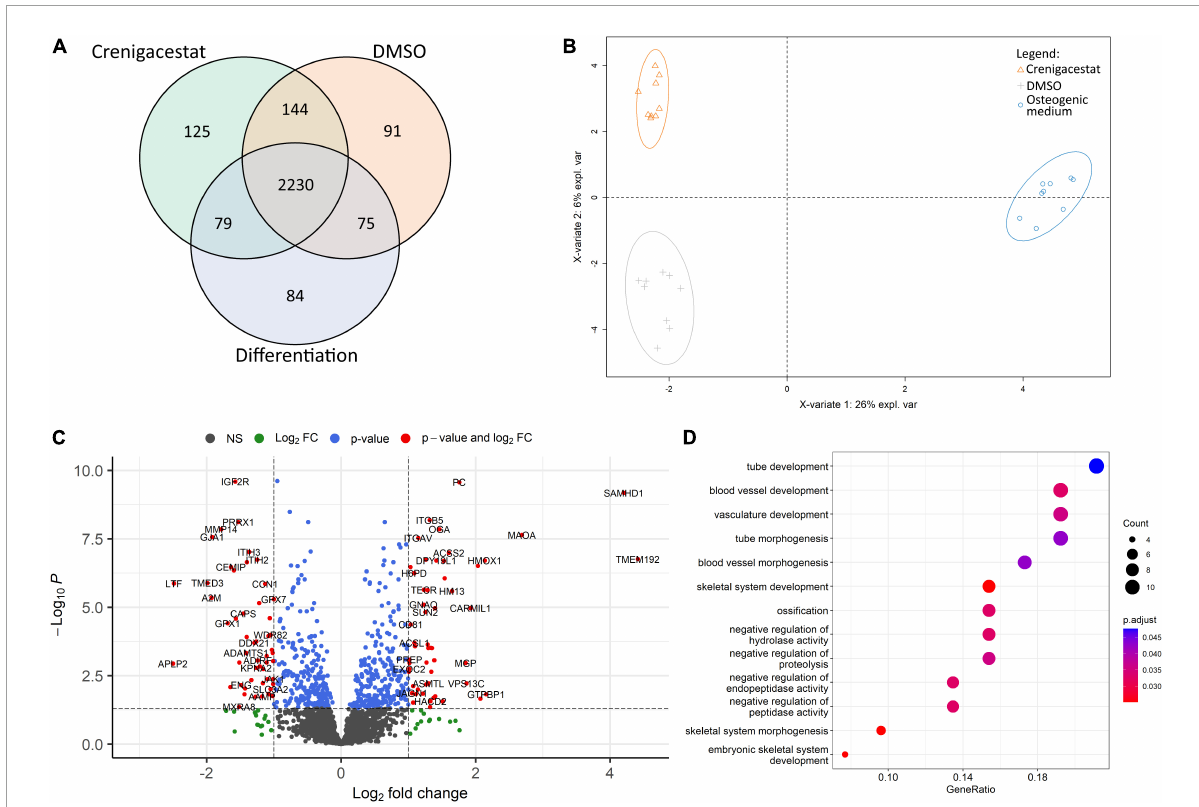
FIGURE4 Comparison of proteomics profiles of human valve interstitial cells (VICs) cultured for 10 days in osteogenic medium (OM), OM supplemented with DMSO (DMSO), OM supplemented with 100 nM of crenigacestat (LY3039478) dissolved in DMSO (Crenigacestat). (A) Venn diagram representing proteins unique for biological groups compared by shotgun proteomics. (B) Partial least-squares discriminant analysis. (C) Volcano plot representing differentially expressed proteins (protein names were converted to gene symbols) of VICs cultured with OM supplemented with crenigacestat against VICs cultured with OM and OM supplemented with DMSO. Log2Fold Change, level of change in expression; -Log10P, negative logarithm of the p -value. Dotted lines cut off transcripts with p -value < 0.05 and Log2Fold Change > |1|. (D) Results of Gene Ontology term enrichment analysis of proteins downregulated in VICs by crenigacestat